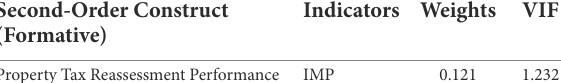
TABLE 3 Measurement model for the first-order constructs. TABLE 4 Measurement model for the second-order construct.